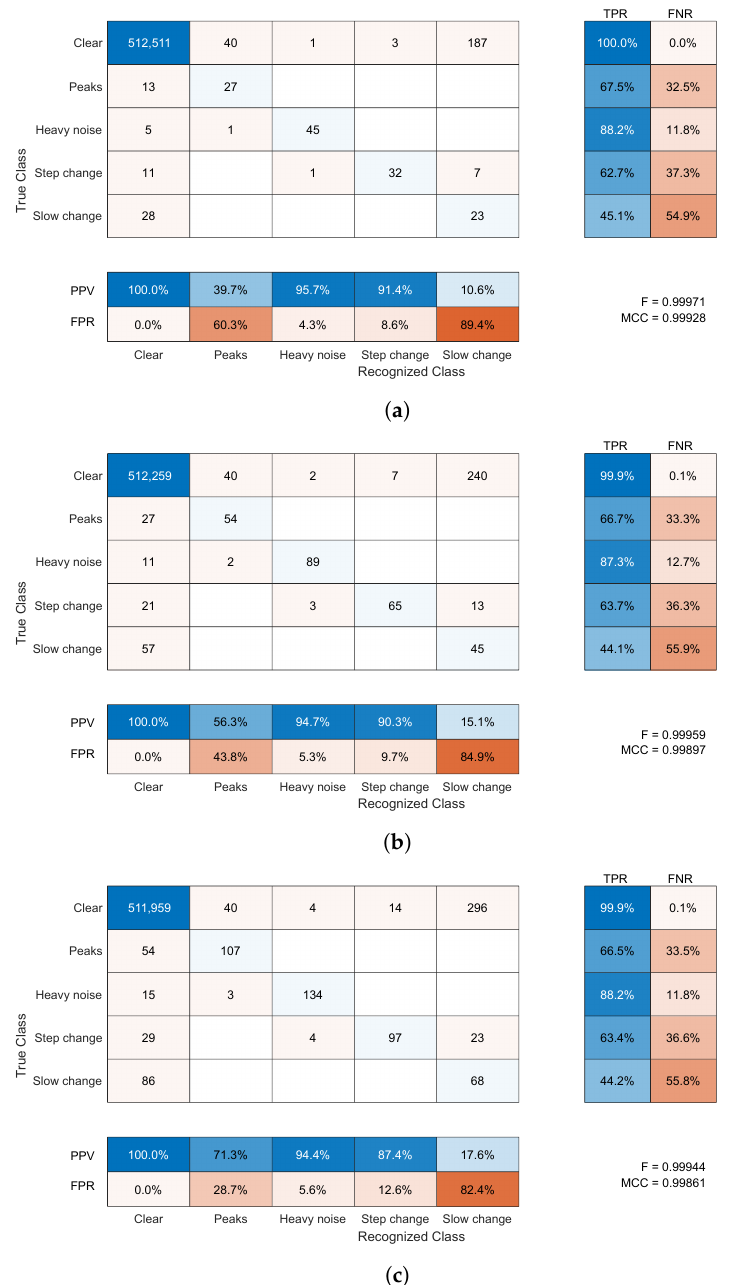
Figure 13. Average confusion matrix for detection of synthetic noises for a 1000-fold simulation with 5-mm average amplitudes of distortions and shares: ( a ) 5%, ( b ) 10%, ( c ) 20% of time (blue—successful results,